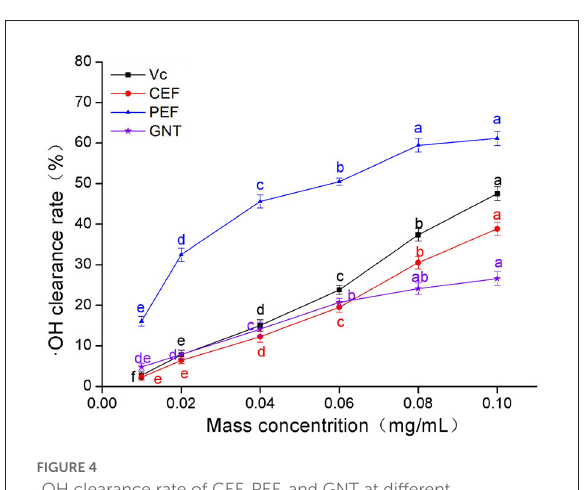
FIGURE4 · OH clearance rate of CEF, PEF, and GNT at different concentrations. Different letters indicate significant differences in · OH scavenging ability of the same substance at different concentrations ( p < 0.05).